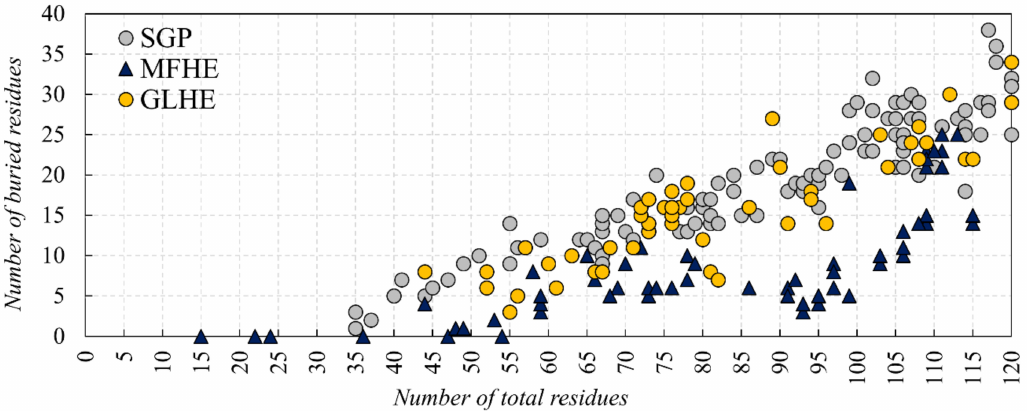
Figure 5. The number of total and buried residues of SGP (grey), GLHE (yellow) and MFHE (blue). For the number of total and buried residues of homodimeric MSF see Figure